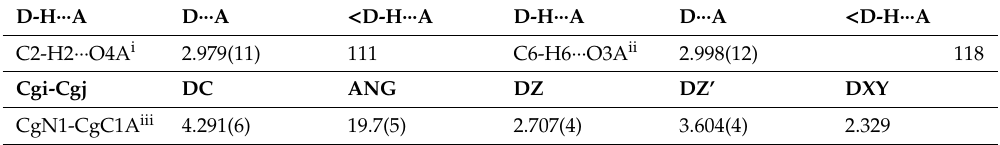
Figure 2. ( a ) View of the hybrid layers in 1.ah parallel to the (001) plane; ( b ) View of the staking of the layers along the x axis. Interactions between aromatic rings are represented as dotted red lines. CgN1: N1, C2, C3, C4, C5, C6; CgC1A: C1A, C2A, C3A, C1A_c, C2A_c, C3A_c. Table 4. Distances (Å) and angles (°) of supramolecular hydrogen bonding and π-π interactions in 1.ah .